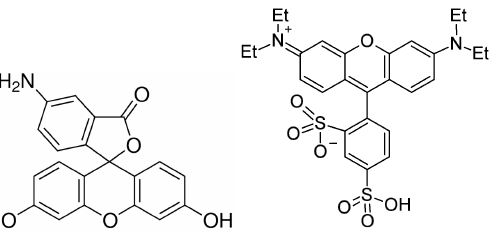
Figure 6. Structures of fluoresceinamine ( left ) and sulforhodamine B ( right ).